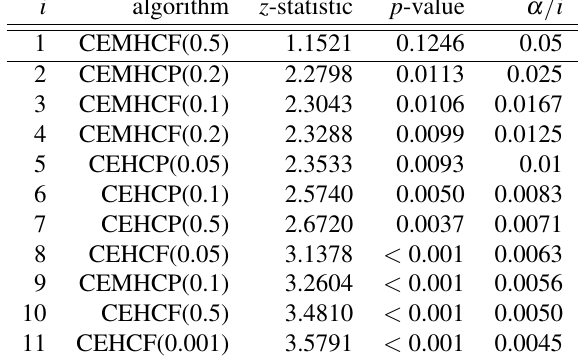
Table 5: Results of Holm’s test using CEMHCP(0.5) as control algorithm ( α = 0 :